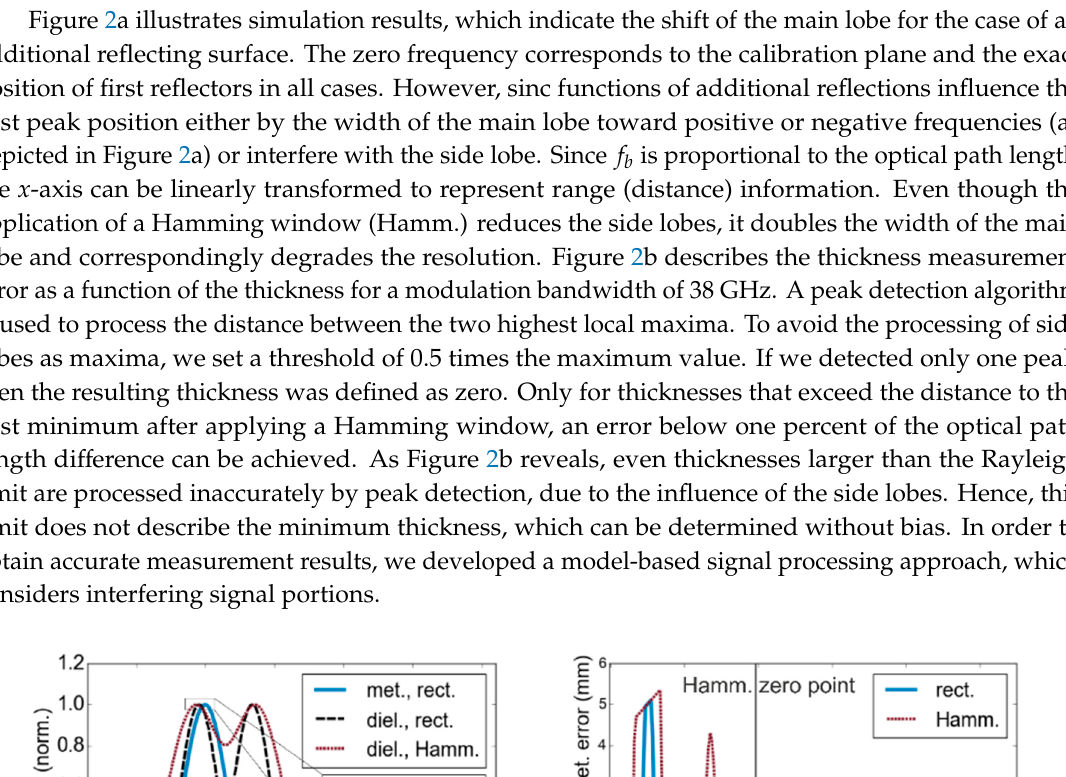
Figure 1. ( a ) Main (solid lines) and multiple reflections (dashed lines) within a multilayer sample under test (SUT) ( b ) Schematic of the measurement setup. VCO, voltage-controlled oscillator; DAQ, data acquisition unit; PC, personal computer; dir., directional; 6. harm., 6-th harmonic; IF, intermediate frequency.